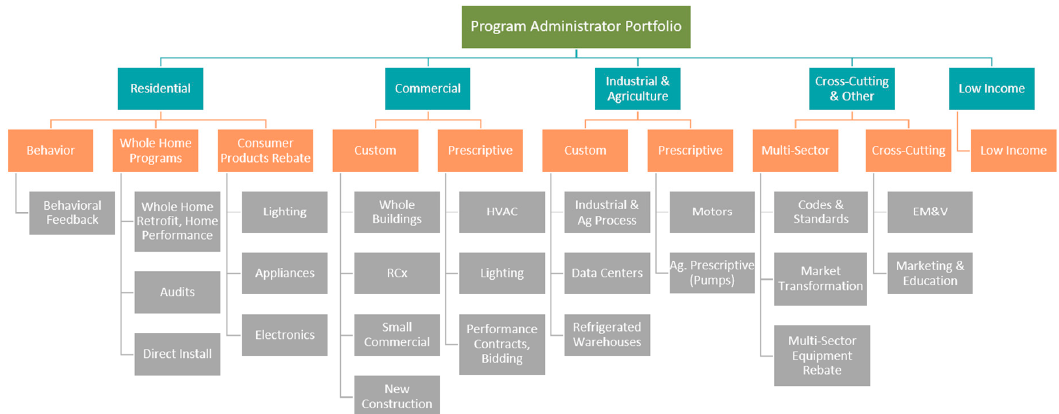
Figure 2. Selected program types in the LBNL program typology. Note: Not all market sectors and simplified and detailed program categories are shown in this figure. Ag.: Agricultural; EM&V: Evaluation, Measurement, and Verification; HVAC: Heating, Ventilation, and Air Conditioning; RCx: